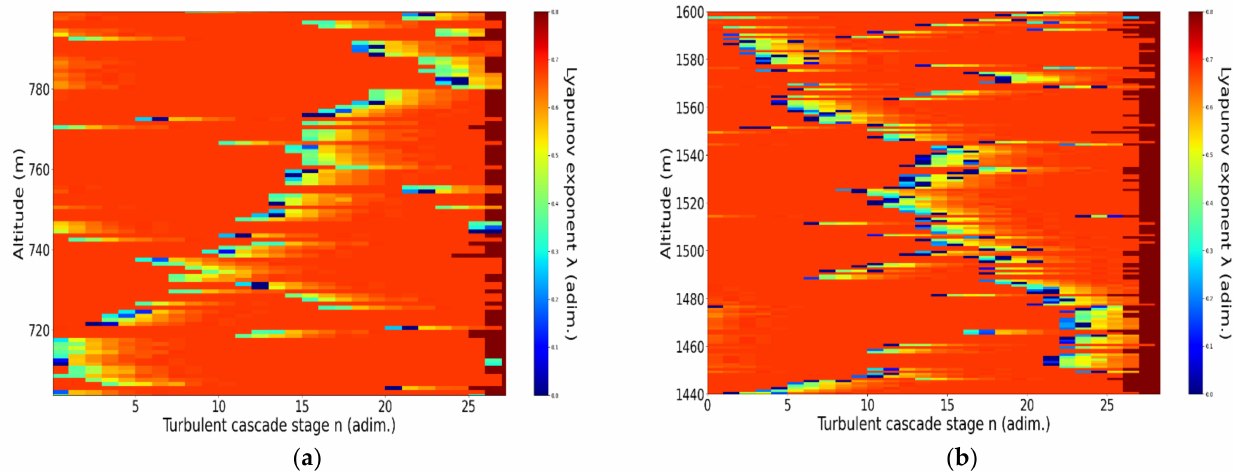
Figure 14. Laminar channels found in the Lyapunov exponent per turbulent cascade stage colormap altitude plot, 21 April 2018: ( a ) ascending; ( b )